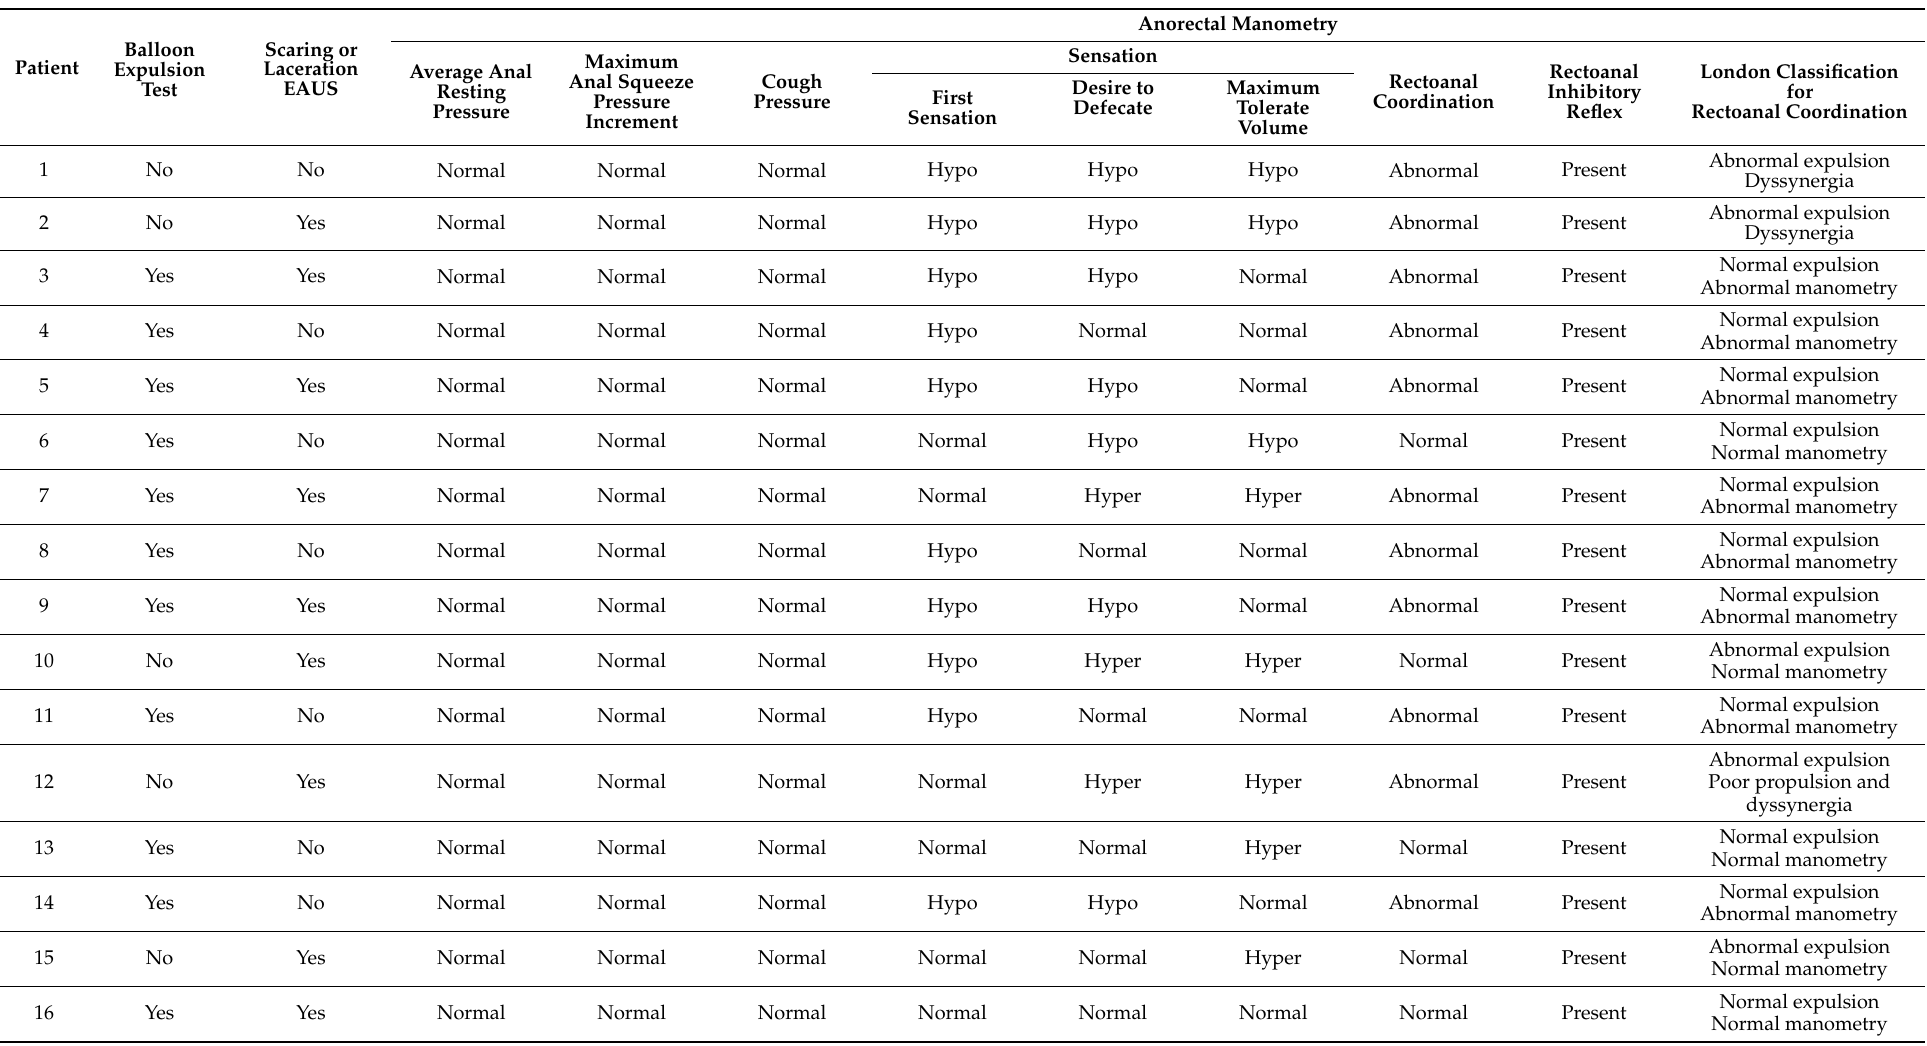
Table 2. Balloon expulsion test, anorectal manometry, and endoanal ultrasound